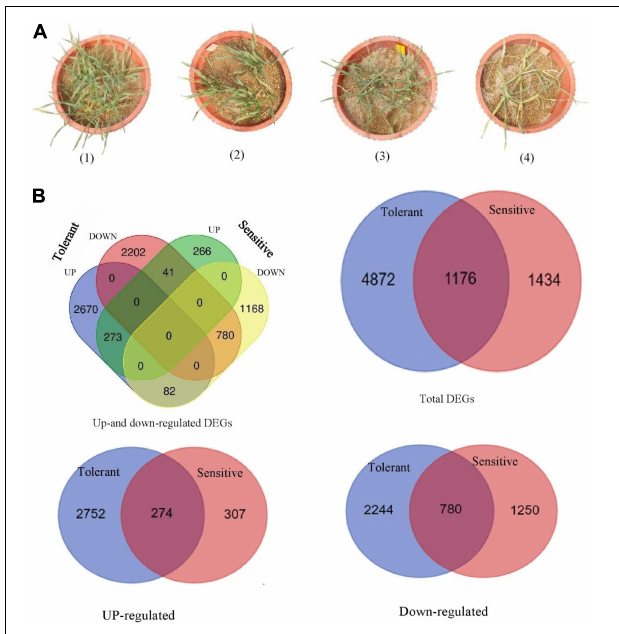
FIGURE 1 | (A) Growth performance of tolerant genotype (pot no. 1 and 3) and sensitive cultivar (pot no. 2 and 4) under control (two pots on the left) and salt stress (two pots on the right) conditions. (B) Venn diagrams showing the number of distinct and common salt-responsive genes (DEGs) found in two barley subspecies (wild salt-tolerant genotype and ‘Mona’ salt-sensitive cultivar).